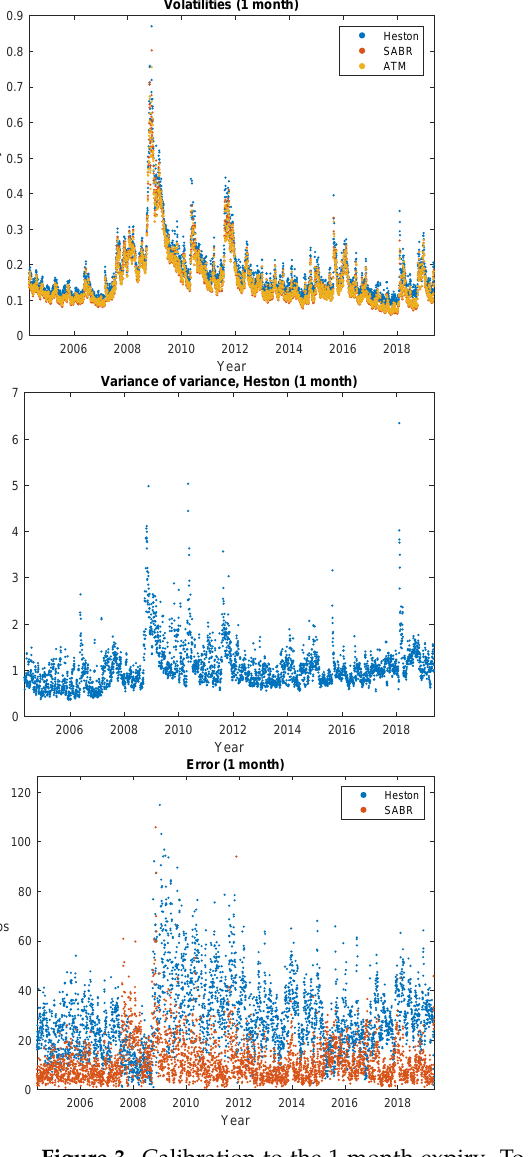
Figure 3. Calibration to the 1 month expiry. To improve visibility, we have in the bottom left plot excluded the extreme errors on the 21st of November 2008 of 260 bps (Heston) and 352 bps